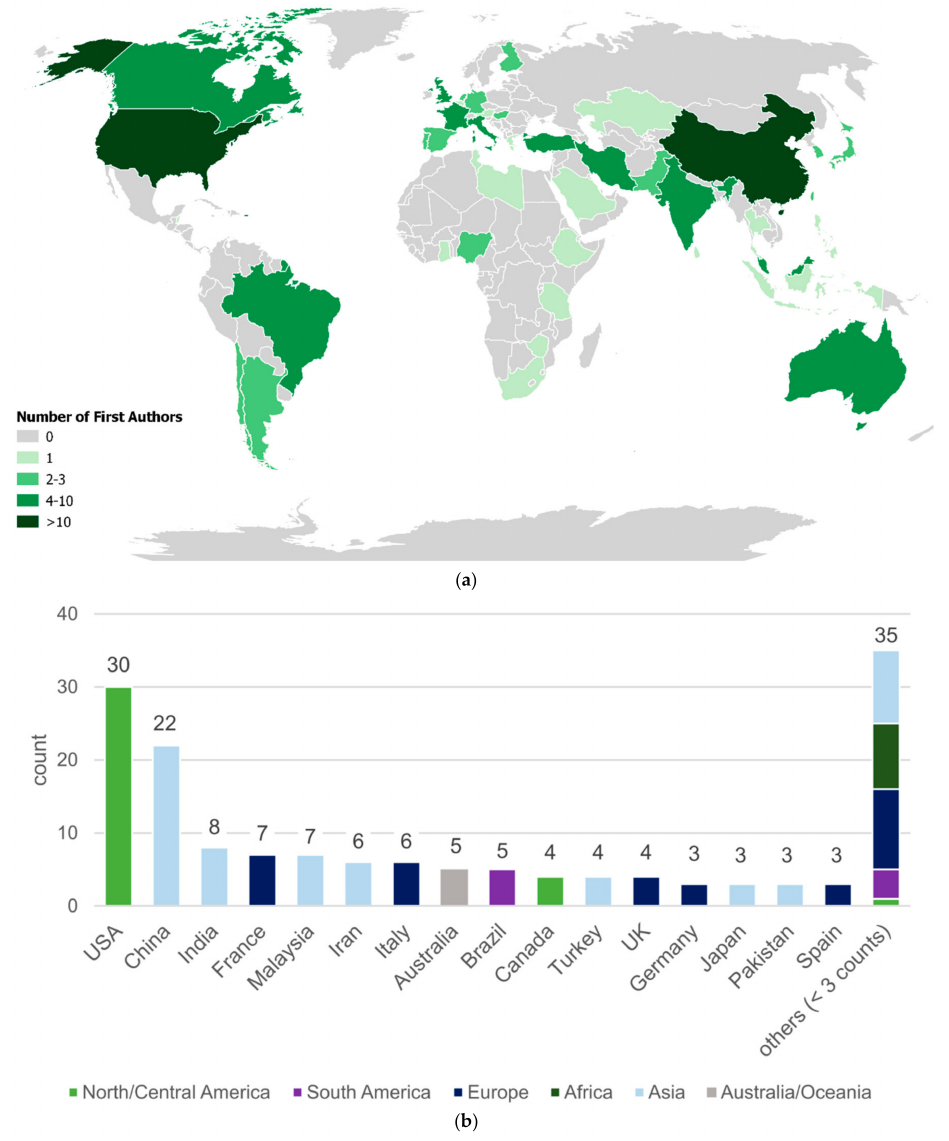
Figure 5. Nationality of the first authors: ( a ) Number of first authors by nationality; ( b ) Total number of authors per nationality and continent. Nationality is determined by the research facility the first author is a ffi liated to. One author may have multiple a ffi liations and therefore